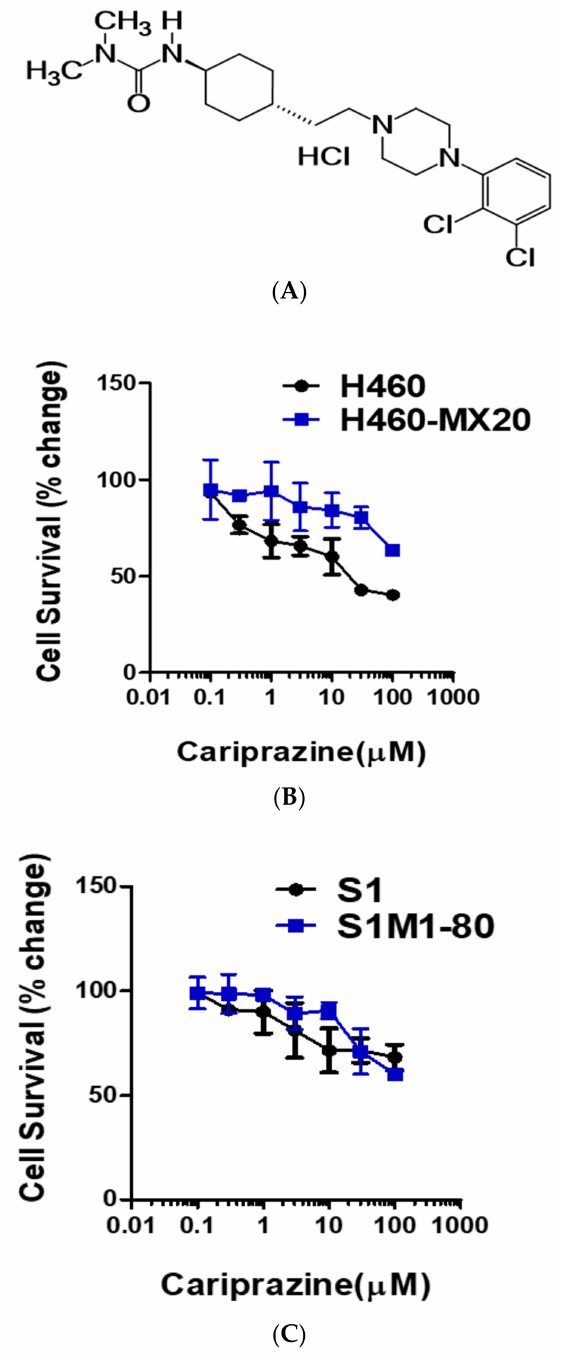
Figure 1. ( A ) Chemical structure of cariprazine. ( B ) 3-(4,5-Dimethylthiazol-2-yl)-2,5-diphenyltetrazolium bromide (MTT) cytotoxicity assay results are shown for H460 and H460-MX20 cells incubated with cariprazine and ( C ) S1 and S1M1-80 cells incubated with cariprazine. The data points represent the mean ± SD of at least three independent experiments repeated in